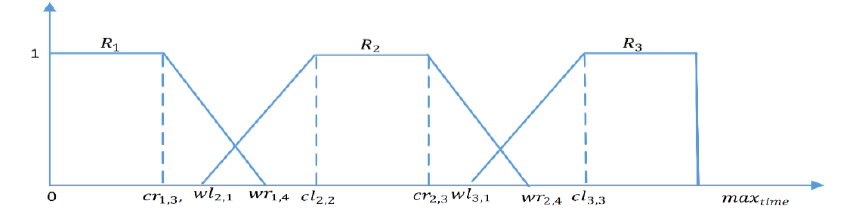
Figure 6. A trapezoidal membership function with three